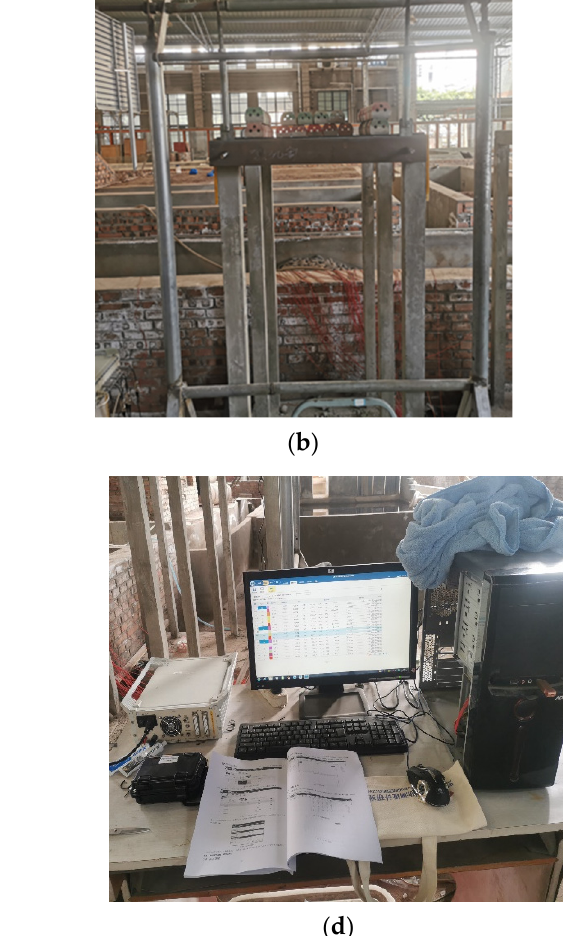
17 of 23 Figure 11. Location of response points in the test model. The external natural excitation (ship impact load) was simulated by pendulum im- pact. Prior to the formal test, a WMS-6303 magnetoelectric pressure sensor was used for test so as to ensure that the test conditions were met. The test instrument was DH5922 dynamic digital acquisition system produced by Jiangsu Donghua Test Technology Co., LTD, Jingjiang City, Jiangsu Province, China, and the sensor was DH1A213E magnetoe- lectric acceleration sensor. The above instruments were used to collect the acceleration response data of the frame and draw the time-history curves during repeated crash tests. In order to distinguish the difference of dynamic response parameters of wharf frame structure before and after damage, the model of undamaged wharf frame was reinforced with wood riveting. When sensors were installed on the frame structure, the test was per-